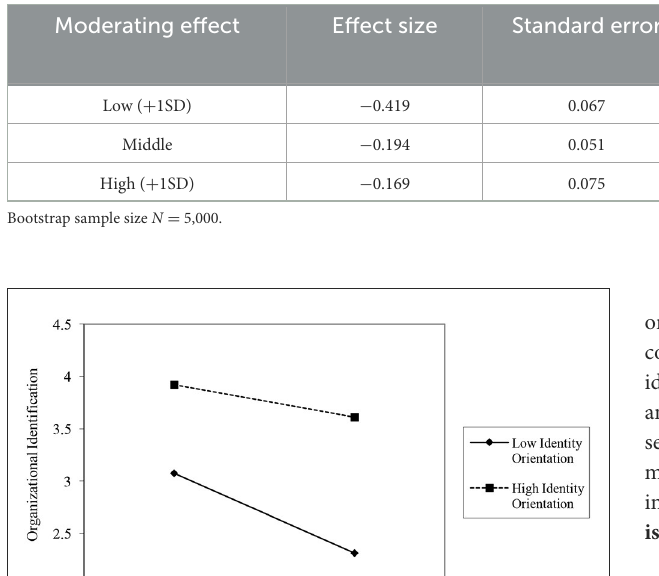
TABLE 7 Bootstrap test of moderating effect.